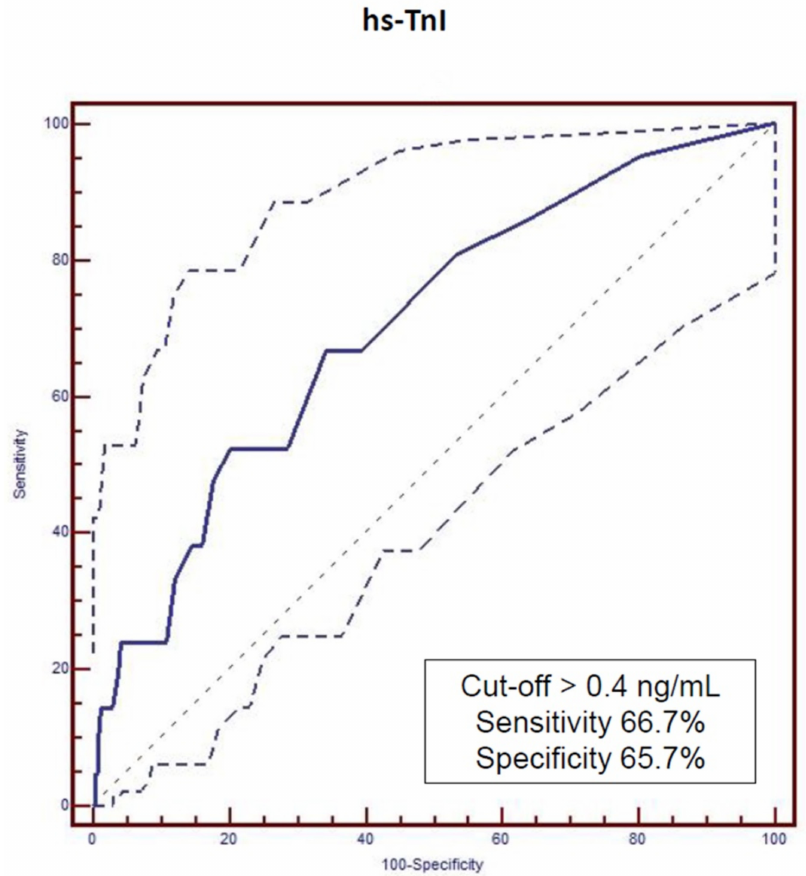
Figure 3. Major adverse cardiovascular events (MACE) cut-off values of high sensitive troponin I (hs-TnI) estimated by ROC